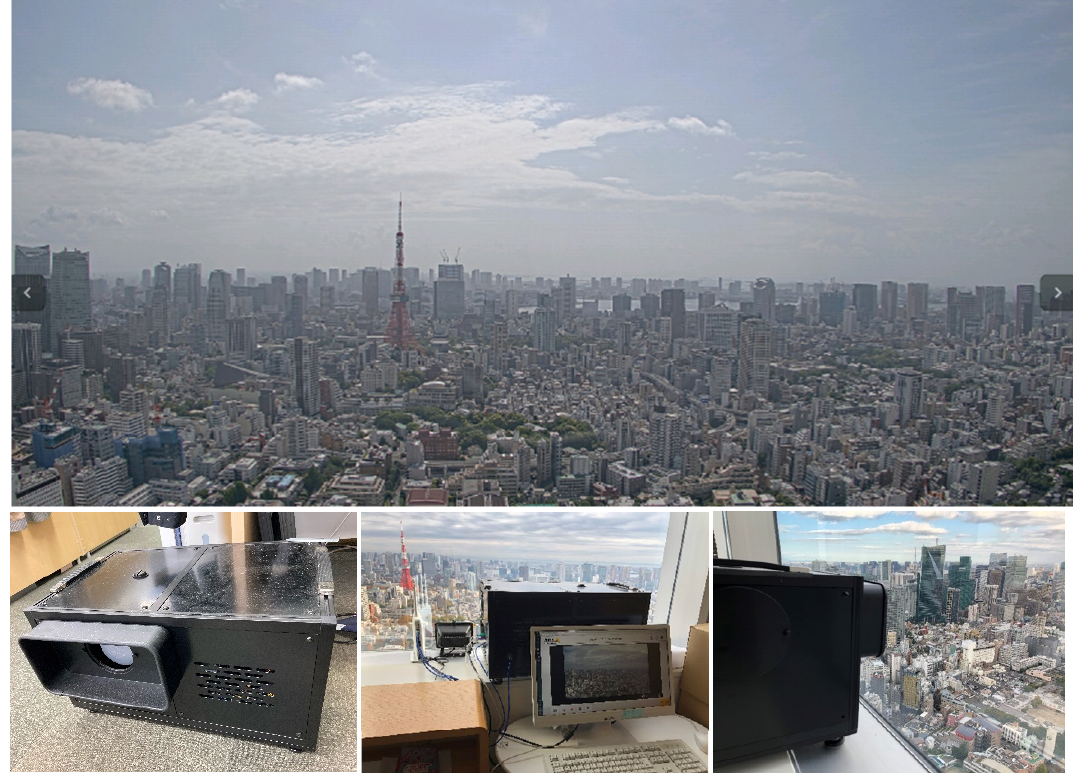
Figure 2. Image captured by the monitoring system and system installation.